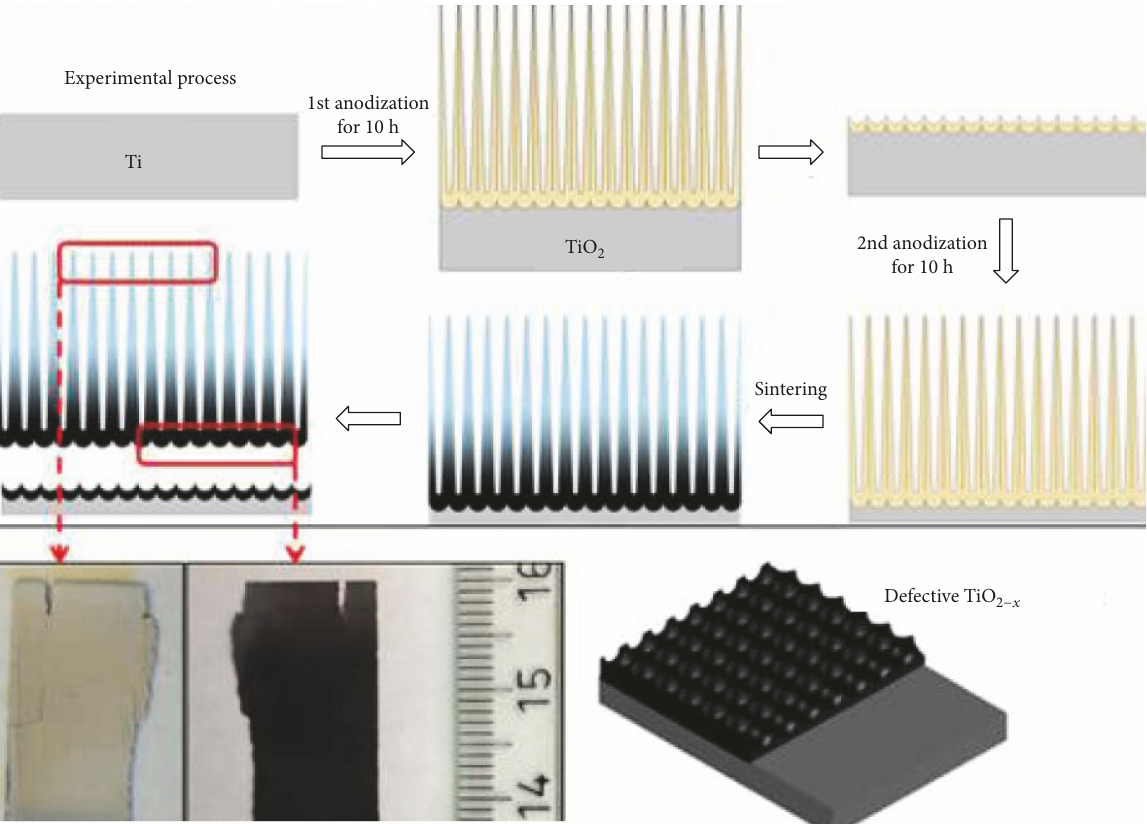
Figure 12: Experimental process and optical images of the stripped TiO American Chemical